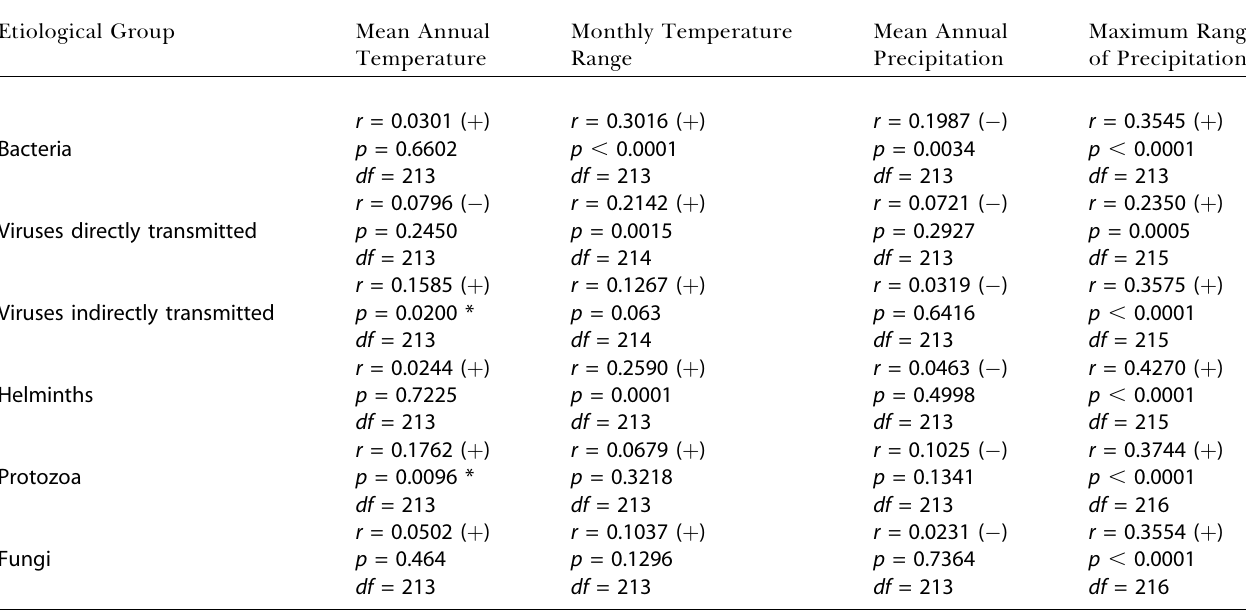
Table 2. Relationship Between PID Species Richness by Etiological Group and Four Bio-Climatic Factors Etiological